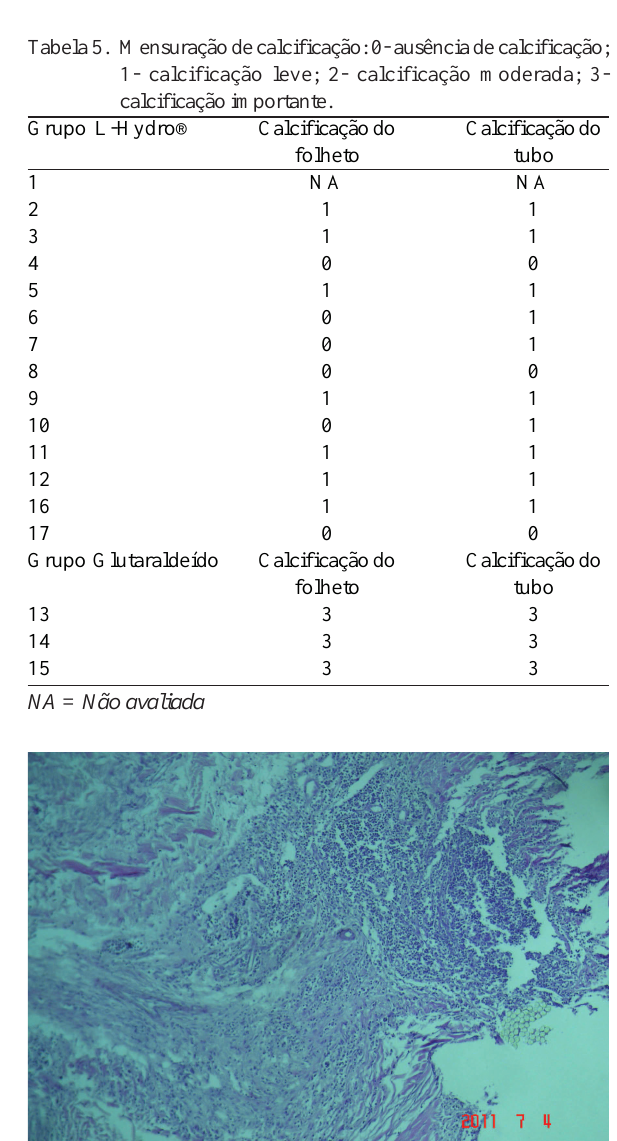
Fig. 5 - Aspecto microscópico (microscopia ótica) das próteses preservadas em glutaraldeído. Coloração em hematoxilina-eosina. Em lilás, regiões de calcificação difusa e grave